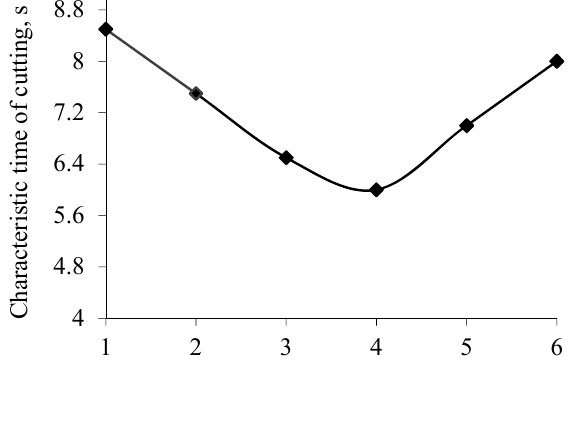
Variant of ingredient proportion Fig. 10. Diagram of force distribution over time when breaking down bar mixture with different ingredient proportions (1 – 100 : 43 : 2; 2 – 105 : 38 : 2; 3 – 110 : 33 : 2; 4 – 110 : 32 : 3; 5 – 105 : 37 : 3; 6 – 100 : 42 : 3).